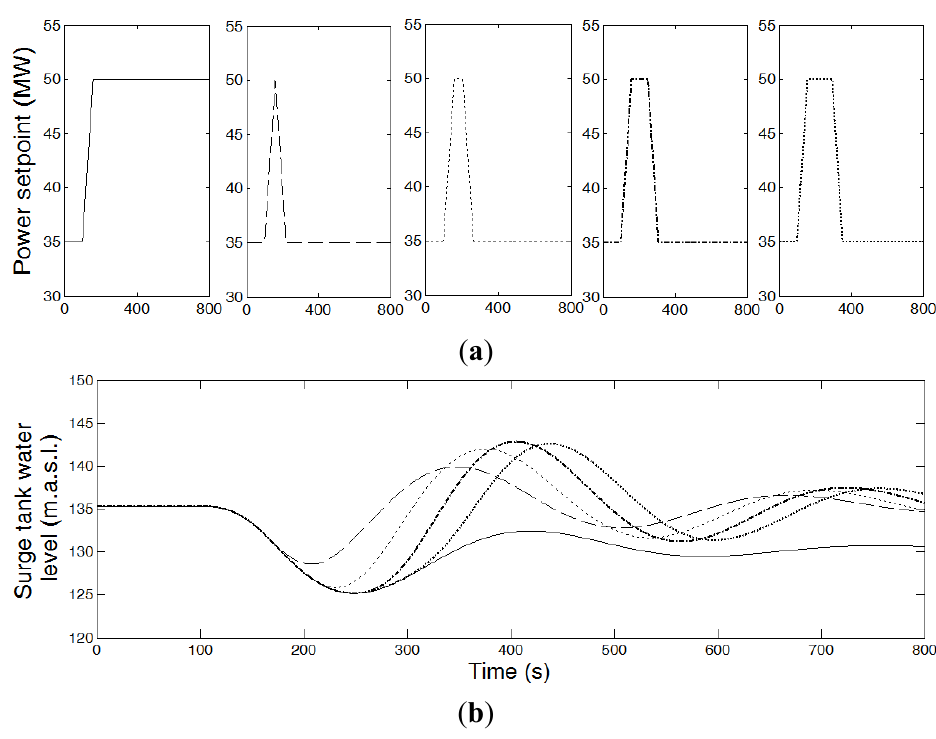
Figure 9. Evolution of the surge tank water level in response to different sequences of up- and down-ward power set-point ramp signals: ( a ) sequences of power set-point signals; ( b ) Evolution of the surge tank water level in response to the power set-point